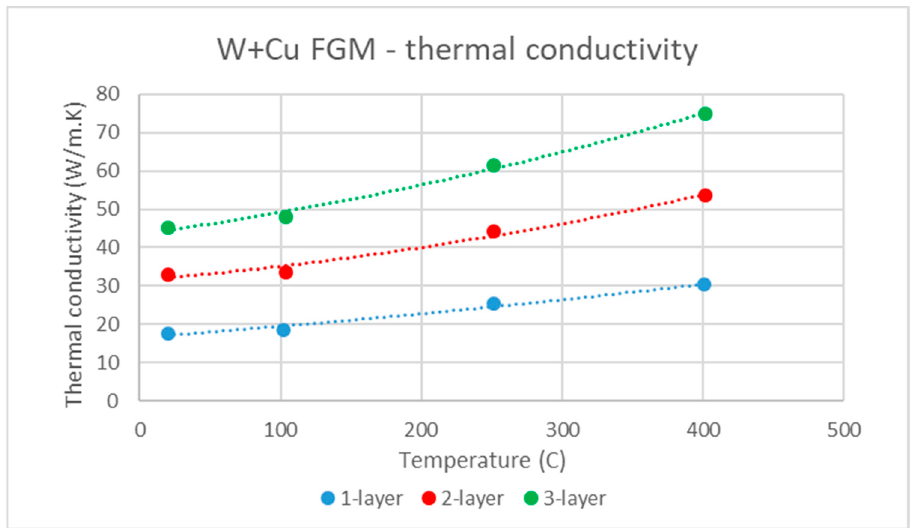
Figure 11. Temperature dependence of thermal conductivity of samples taken from the one-, two-, and three-layer regions of the functionally graded material (FGM).